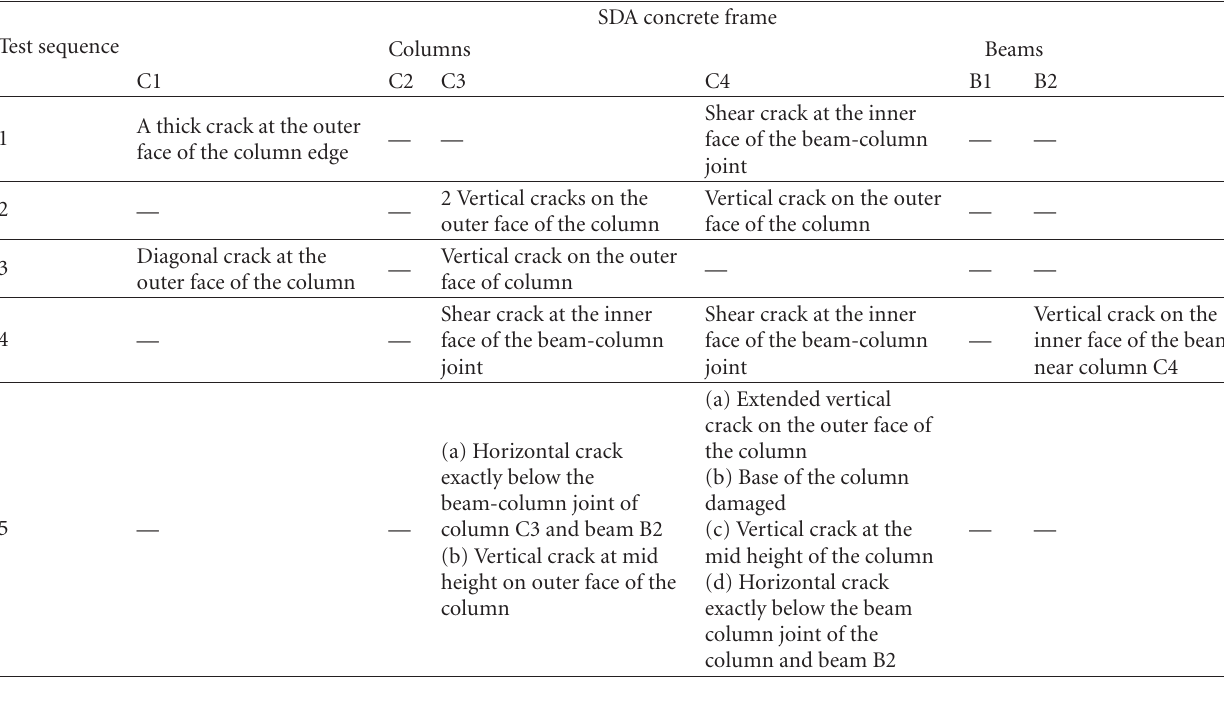
Table 9: Damage assessment of SDA concrete frame.